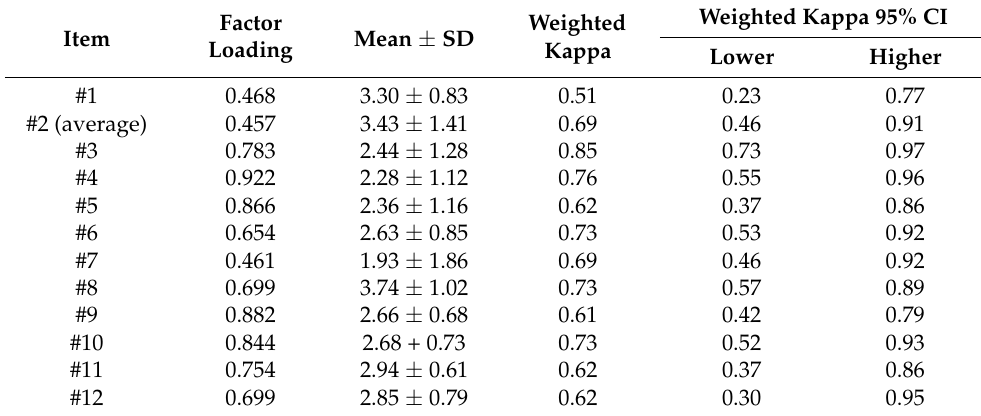
Table 5. Factor loadings, mean, standard deviation, and weighted kappa of each item of the